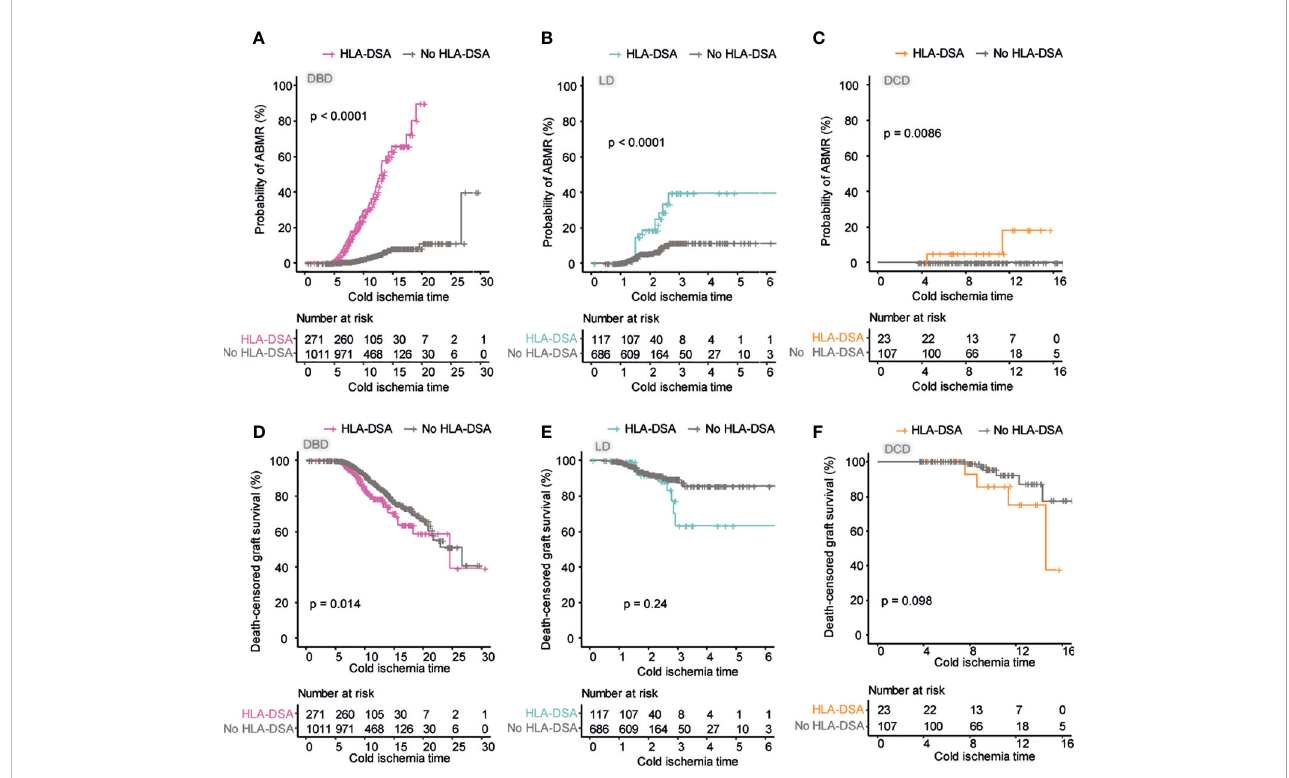
FIGURE 6 Prolonged cold ischemia time has a large in fl uence on ABMR risk in DSA positive patients. Cumulative incidence of ABMR in patients who received DBD transplants (A) , LD transplants (B) , and DCD transplants (C) in relation to cold ischemia time. Cumulative incidence of death-censored graft survival in patients who received DBD transplants (D) , LD transplants (E) , and DCD transplants (F) in relation to cold ischemia time. Log-rank test was used to test p value of the Kaplan-Meier survival curves for all the